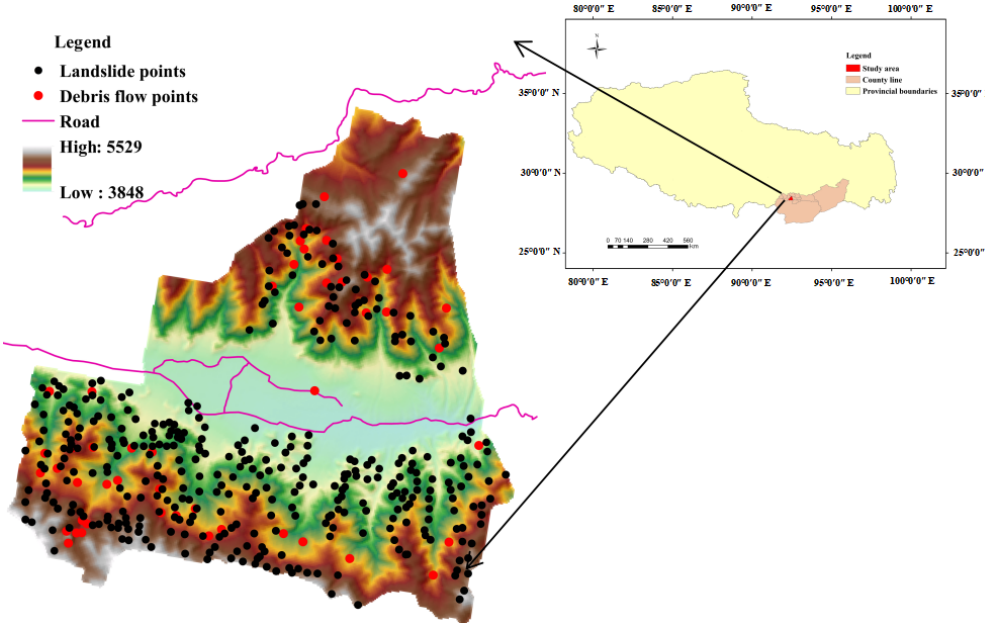
Figure 1. Location map of the study area showing the landslide and debris flow